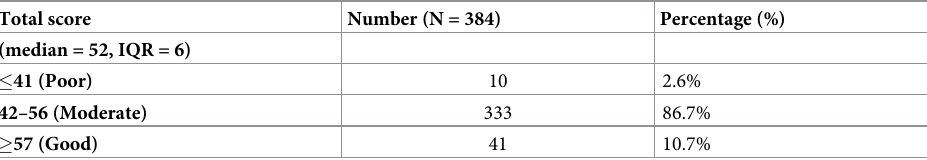
Table 3. The respondents’ levels of knowledge of doping (N = 384).